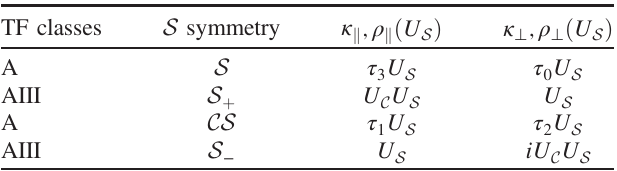
TABLE XX. The mapped representation of the unitary order- two (anti)symmetry S under application of the dimension-raising isomorphisms κ , κ ⊥ , ρ , and ρ ⊥ for the complex tenfold-way k k classes. The mapping of the Hamiltonian and the tenfold-way symmetries is given in Table XVIII.